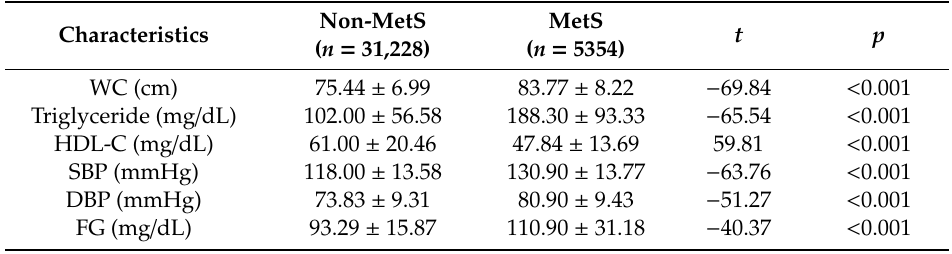
Table 2. Comparison of metabolic syndrome risk factors between non-metabolic (Non-MetS) and metabolic (MetS) syndrome